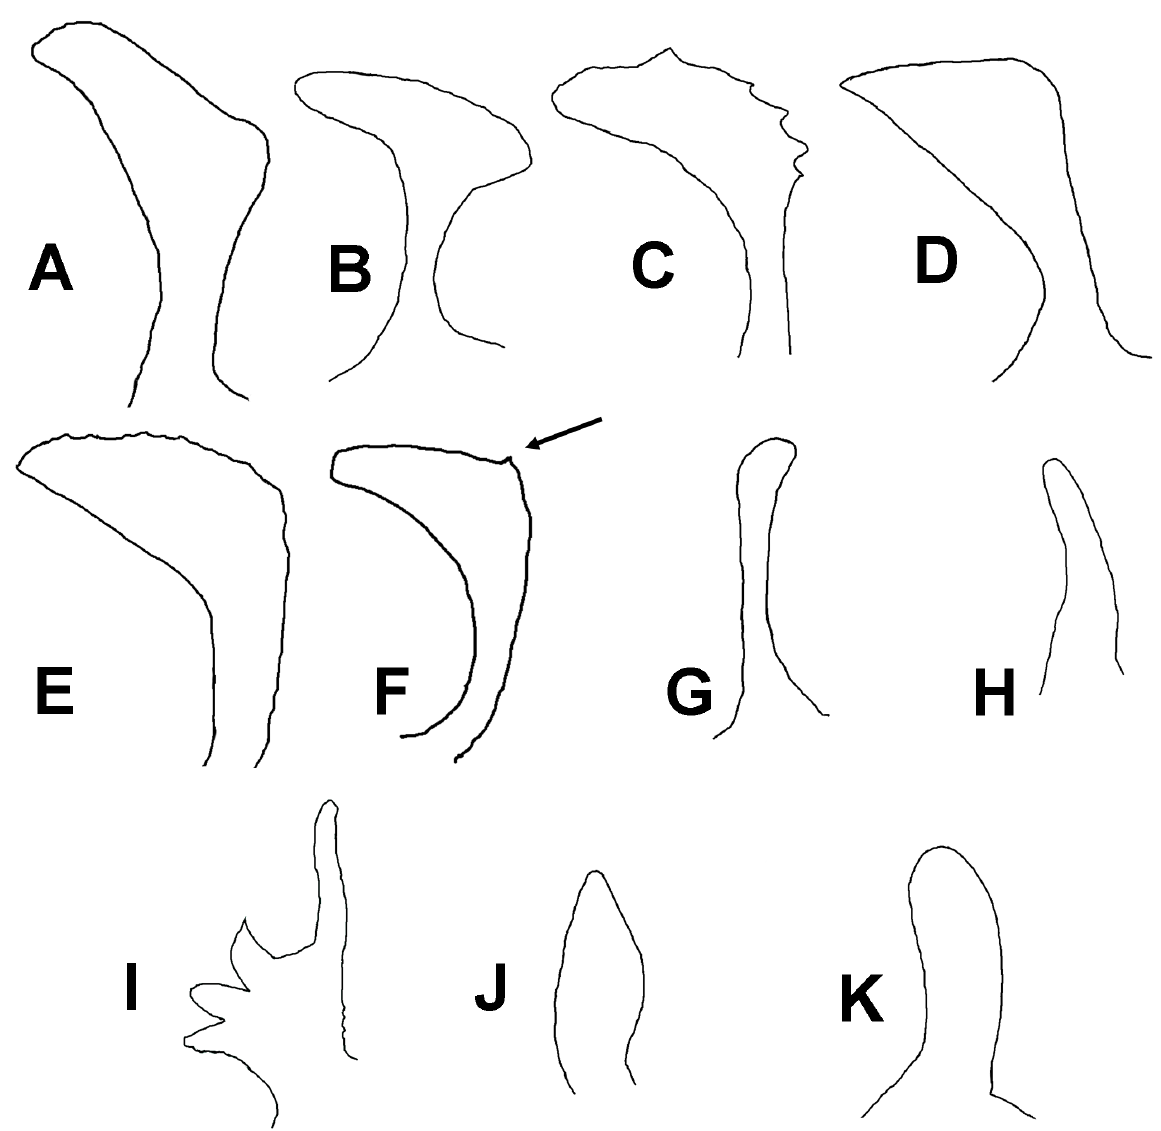
Fig. 11. Prionopetalum spp., outlines of proximal telomere process ( tpp) . A . P. aculeatum (based on Attems 1914). B . P. ndelei (based on VandenSpiegel & Pierrard 2009). C . P. serratum (based on Attems 1909). D . P. dentigerum (based on Kraus 1960). E . P. tanganjikum (based on Kraus 1960). F . P. xerophilum (based on Kraus 1960). G . P. clarum (based on Kraus 1960). H . P. pulchellum (based on Kraus 1960). I . P. kraepelini (orig.). J . P. fryeri (based on Kraus 1960). K . P. asperginis sp. nov. (orig.). Not to